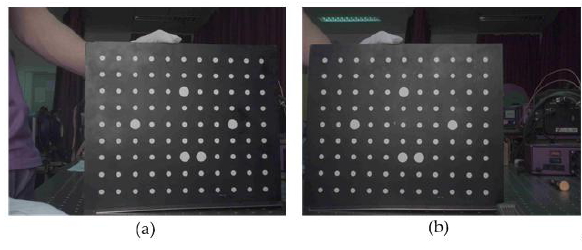
Figure 6. Calibration images of the left (a) and right (b) cameras